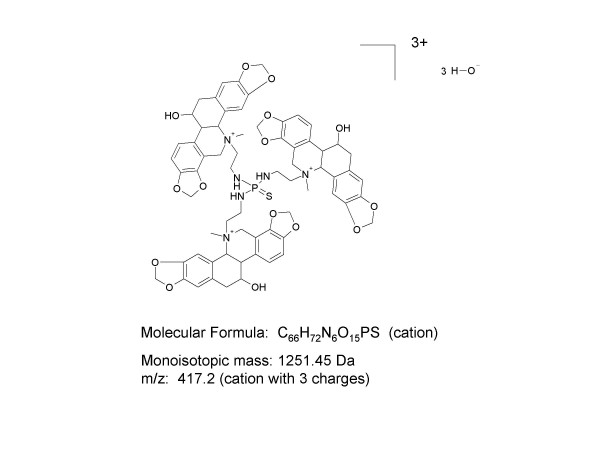
(a) Postulated trimeric structure of the "Ukrain-molecule".